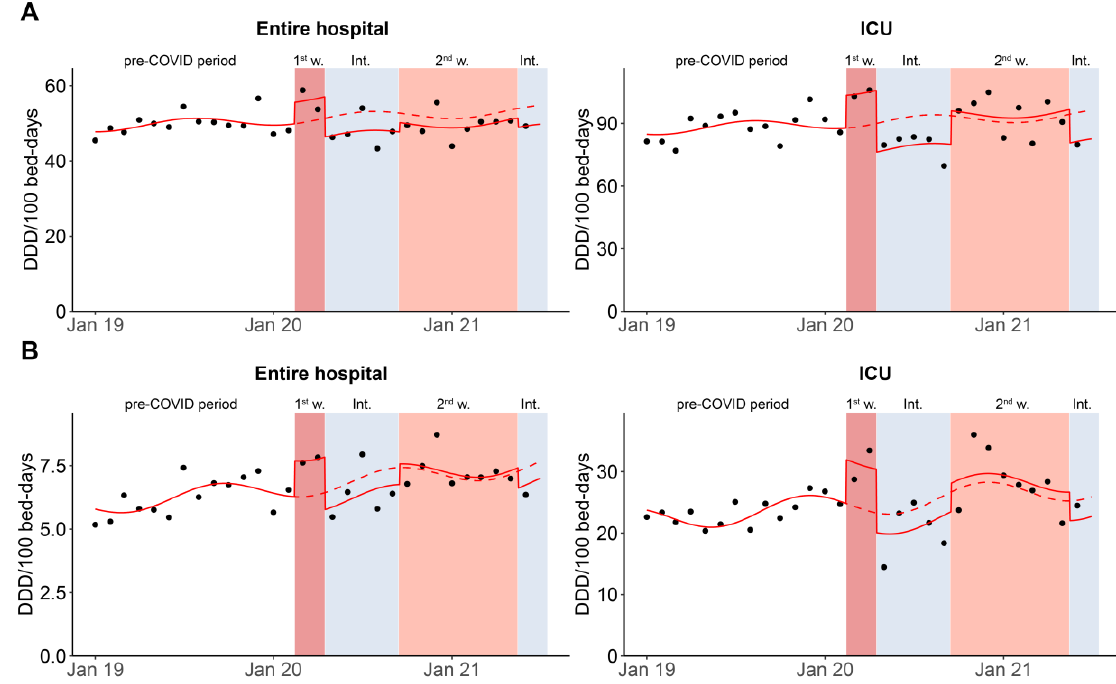
Figure 3. Analysis of monthly antibiotic consumption using the ANRESIS subset, measured in DDD per 100 bed-days for ( A ) all antibiotics for systemic use (ATC code J01) and ( B ) broad-spectrum antibiotics only, for the entire hospital and ICUs between January 2019 and June 2021. The graph shows the impact of the two waves of the pandemic (reddish background) on antibiotic consumption, based on a segmented regression analysis. The solid line shows the estimates of the segmented regression model. The dotted line is the estimated regression model assuming that the pandemic had not occurred. The dots show the effective consumption per month. ICU, intensive care unit; 1st w, 1st wave; Int., intermediate periods; 2nd w, 2nd wave.